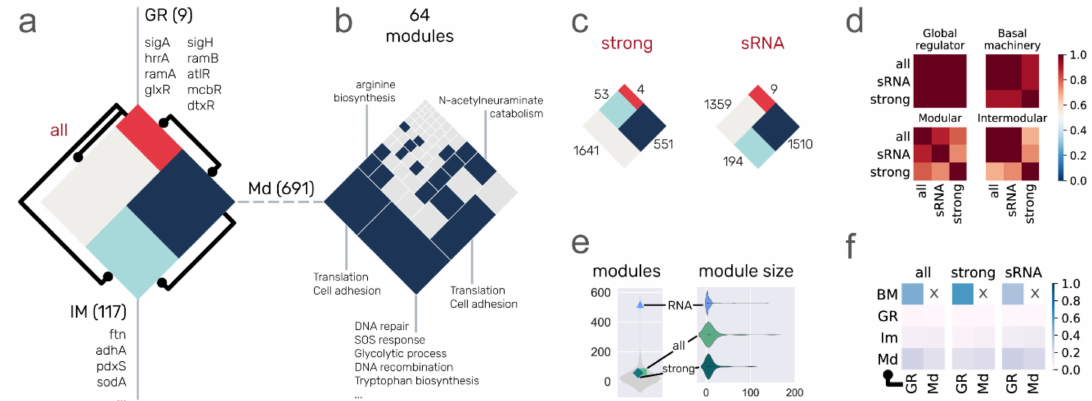
Figure 3. System-level classification of the networks. ( a ) The diamond represents the complete set of nodes in the network, which are classified in one of the four classes: global regulators (red), modular (dark blue), intermodular (light blue), and basal machinery (gray, 1624 nodes). The size of the classes is proportional to the size of the all evidence network on a logarithmic scale. Black lines represent the interactions between the two classes. We listed the global regulators and some examples of intermodular genes. The modular class is further divided into 64 locally independent modules in the all evidence network ( b ). Modules enriched with a biological function are colored in blue. The size of the sections is proportional to the size of the modules. Similar to the all evidence network in panel ( a ), panel ( c ) shows the proportion of the NDA classes for the strong and sRNA networks. ( d ) Heatmaps of similarity index between the three C. glutamicum networks for each one of the four NDA classes. The color bar shows that more than half of the nodes in the class are conserved for each class among the three networks, showing the precision of network node classification. ( e ) Distribution of the number of modules and their size. Light gray distribution of the number of modules was drawn using the nonredundant set of networks, including the three C. glutamicum networks. ( f ) The fraction of network interactions between the four classes for each one of the C. glutamicum